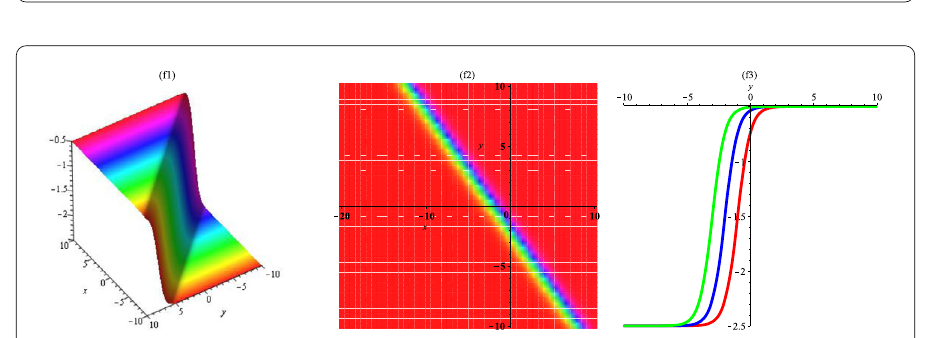
Figure 4 For solution of (2) w , c i = 1, t = 1, z = –20, (f1) 3D plot (f2) density plot and (f3) 2D plot with spaces x = –3,0,3